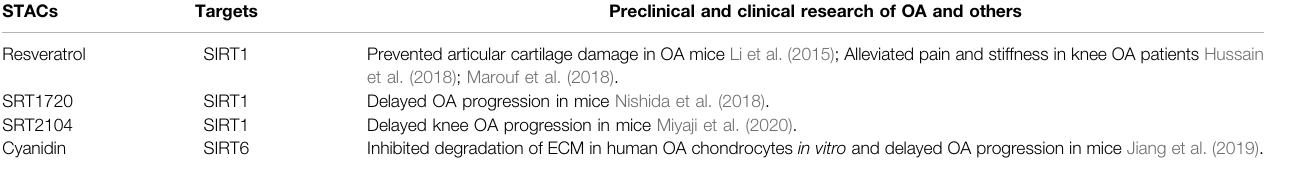
TABLE 1 | STACs on OA treatment.